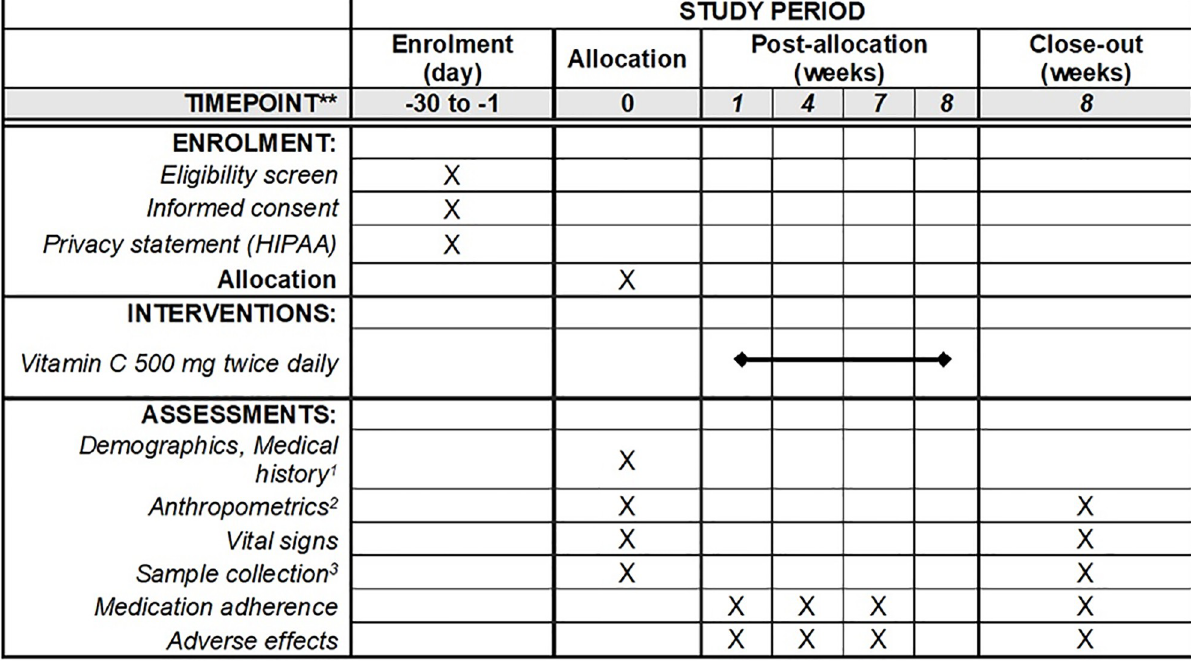
PLOS ONE | https://doi.org/10.1371/journal.pone.0279830 February 1,